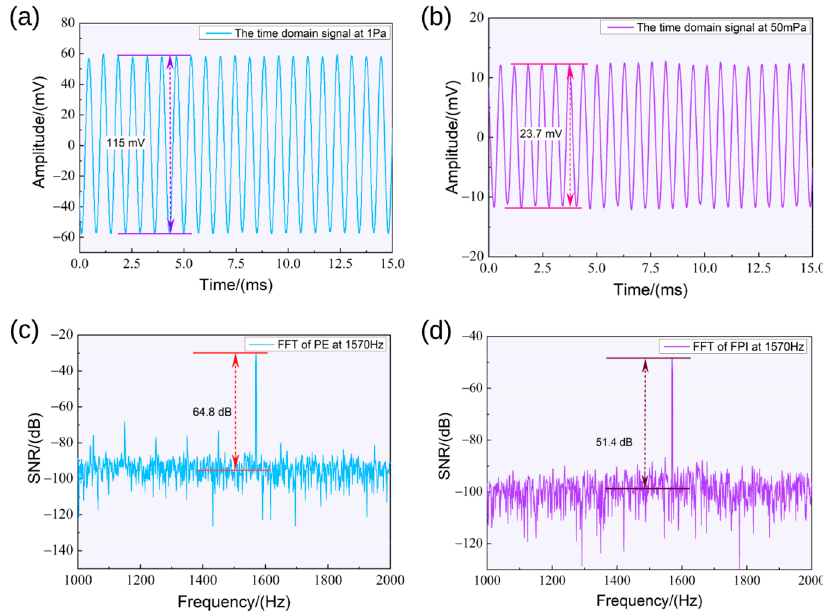
Figure 5. ( a , b ) Time-domain signals of the piezoelectric and FPI effects; ( c , d ) frequency-domain signals of the piezoelectric and FPI effects.